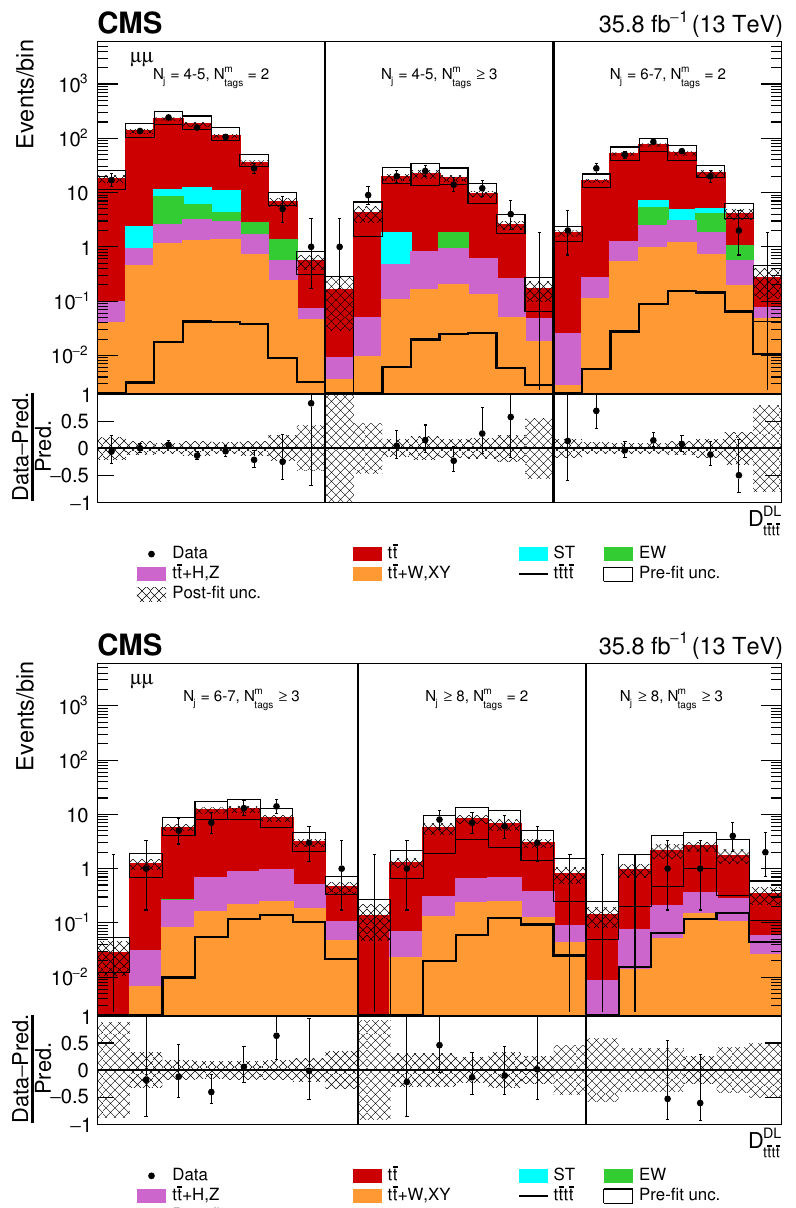
Figure 10 . Post-(cid:12)t D DL distributions in the (cid:22) + (cid:22) (cid:0) channel for events satisfying baseline opposite- tttt sign dilepton selection and (upper row) N = 4{5, N m = 2, (cid:21) 3, N = 6{7, N m = 2 and (lower j tags j tags row) N = 6{7, N m (cid:21) 3, N (cid:21) 8, N m = 2, (cid:21) 3. Dots represent data. Vertical error bars j tags j tags show the statistical uncertainties in data. The post-(cid:12)t background predictions are shown as shaded histograms. Open boxes demonstrate the size of the pre-(cid:12)t uncertainty in the total background and are centered around the pre-(cid:12)t expectation value of the prediction. The hatched area shows the size of the post-(cid:12)t uncertainty in the background prediction. The signal histogram template is shown as a solid line. The lower panel shows the relative di(cid:11)erence of the observed number of events over the post-(cid:12)t background